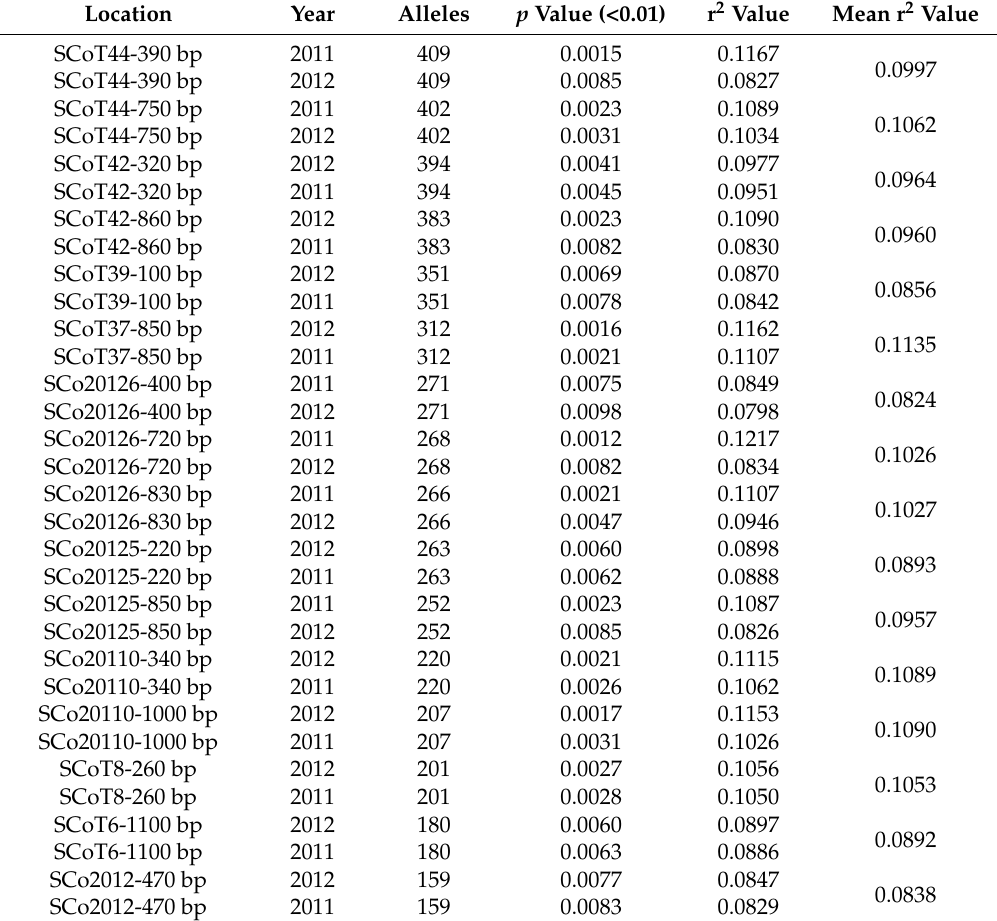
Table 4. The information about alleles that are associated with the rust resistance trait for orchardgrass.